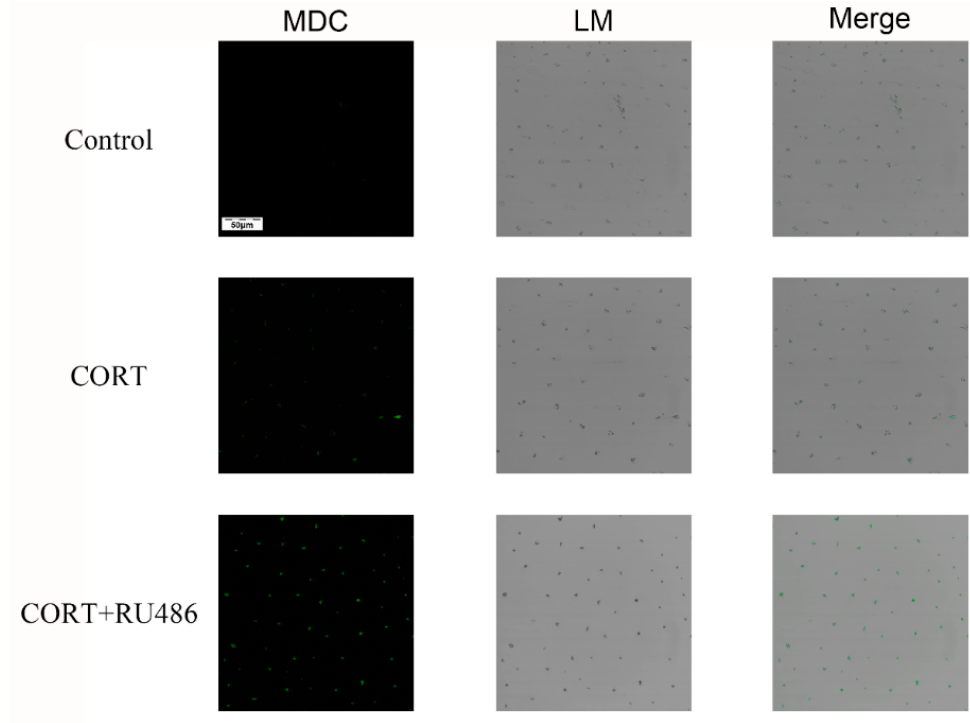
Figure 9. The phenomenon of autophagy in HT22 cells was observed by monodansylcadaverine (MDC) staining after 400 µ M CORT treatment for 3 h with or without RU486 treatment. The green color denotes MDC staining.